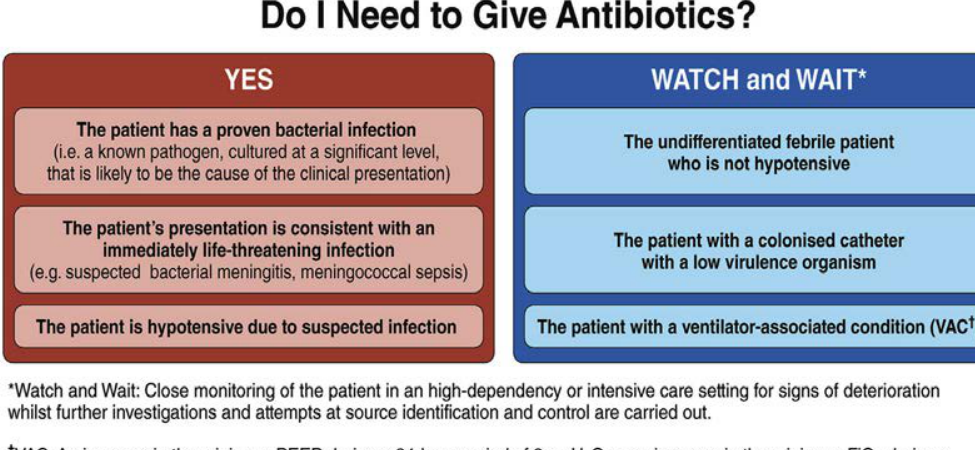
Fig. 8. Do I need to give antibiotics?- Summary 1